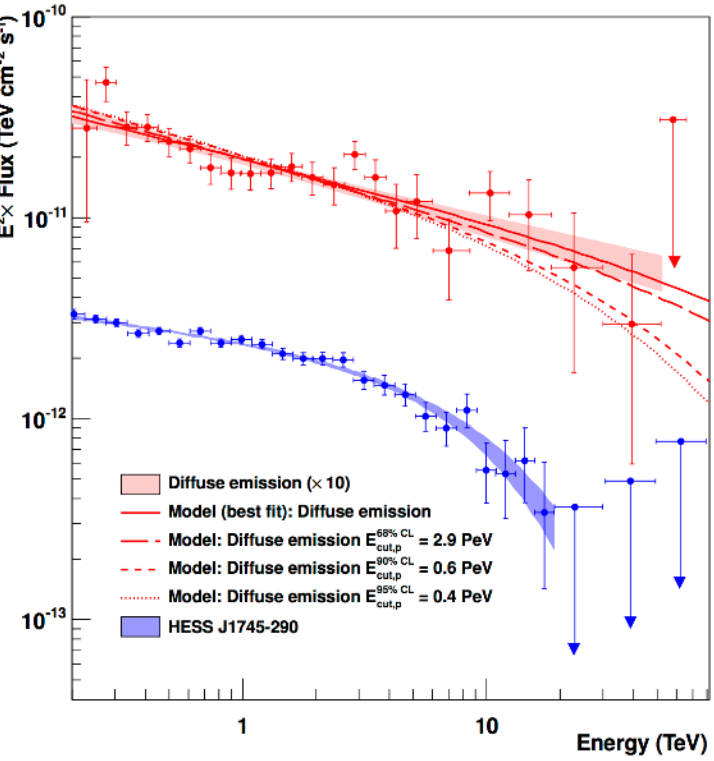
Figure 5. VHE gamma-ray spectra of the diffuse emission and HESS J1745-290. The vertical and horizontal error bars show the 1 σ statistical error and the bin size, respectively. Arrows represent 2 σ flux upper limits. The 1 σ confidence bands of the best-fit spectra of the diffuse and HESS J1745-290 are shown in the red and blue shaded areas, respectively. The red lines show the numerical computations, assuming that gamma rays result from the decay of neutral pions produced by proton–proton interactions. The fluxes of the diffuse emission spectra and models are multiplied by 10 to visually separate them from the HESS J1745-290 spectrum. Figure from